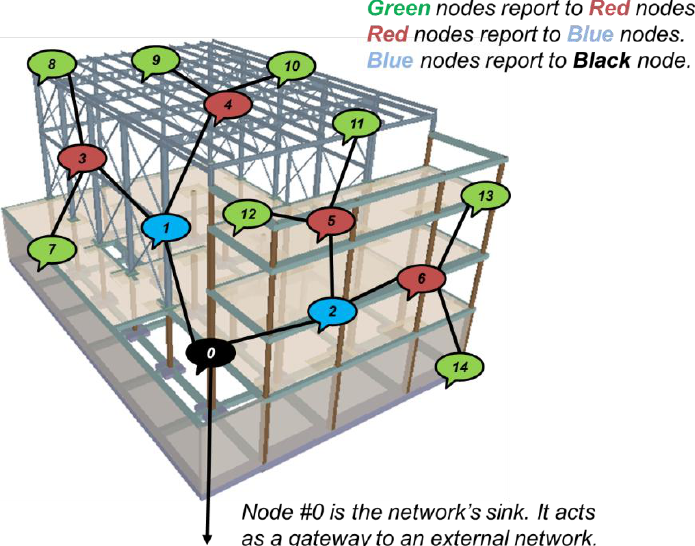
Figure 12. A network of SCM-WuR vibration sensor nodes in a multi-hop scenario.